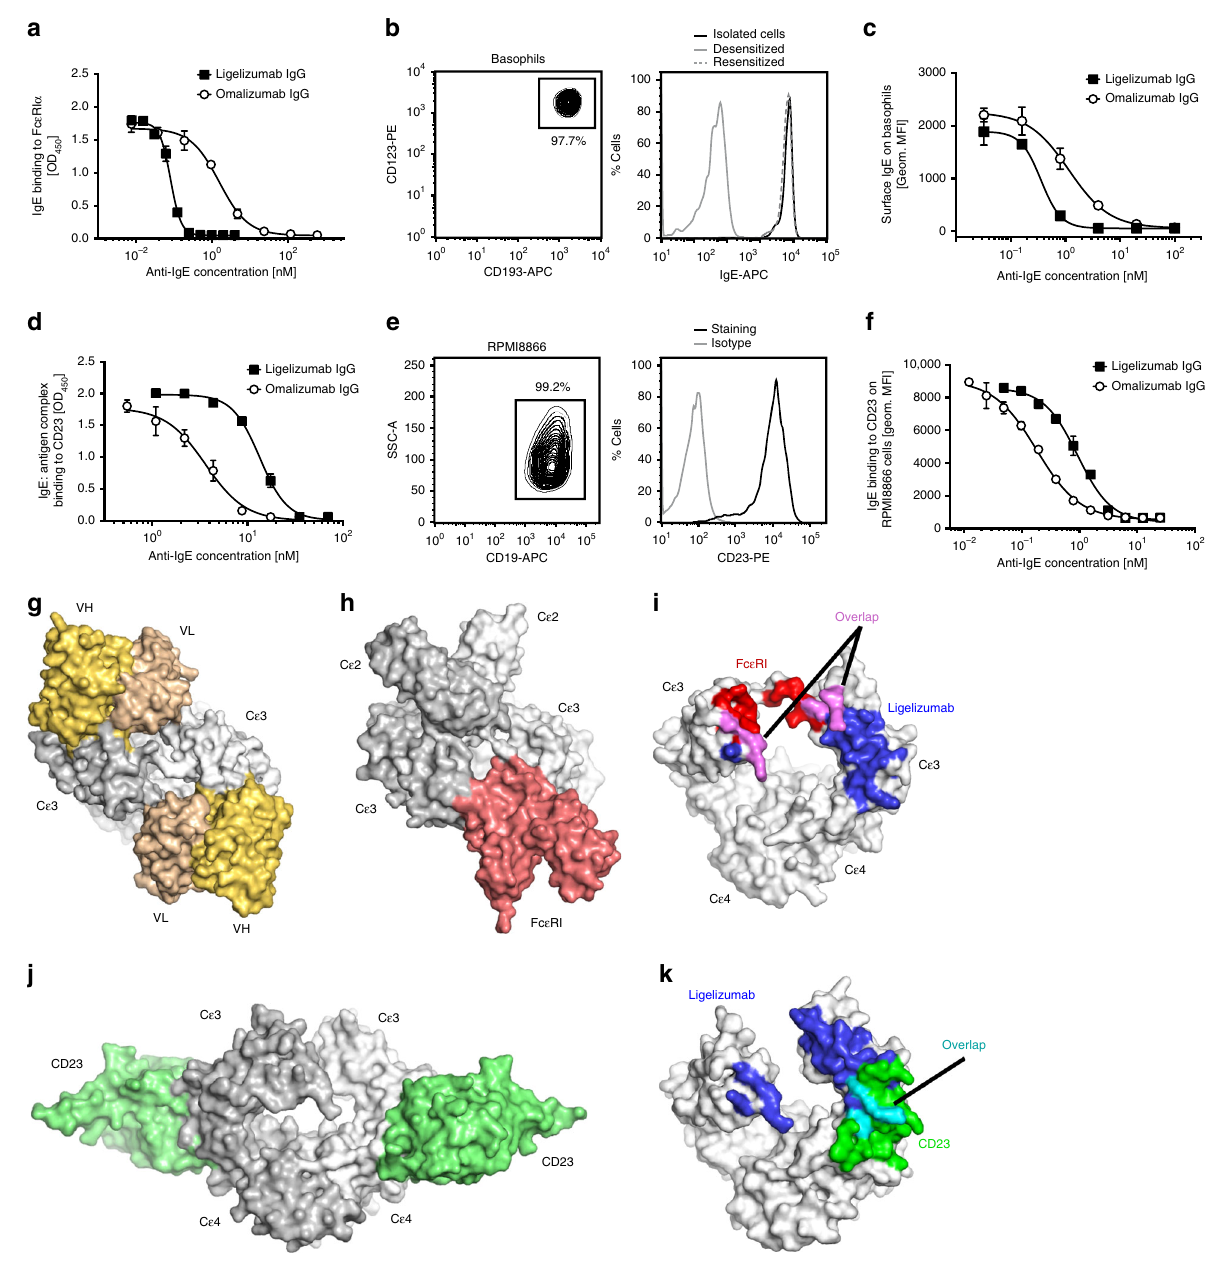
Fig. 2 Inhibition of IgE binding to Fc ε RI α and CD23 by ligelizumab or omalizumab. a Inhibition of IgE binding to Fc ε RI α through ligelizumab or omalizumab IgG by ELISA. b Isolated primary human blood basophils are gated as SSC low , FSC low , CD123 + , CD193 + double-positive cells. A histogram of basophil surface IgE levels before (black line) and after desensitization with 5 µ M disruptive-anti-IgE DARPin ® bi53_79 (gray line) and after resensitization with recombinant human JW8-IgE (dashed gray line) is shown. c Inhibition of IgE binding to Fc ε RI α on isolated bi53_79-treated basophils by ligelizumab or omalizumab IgG. Binding curves were fi tted using a non-linear regression model. d Inhibition of IgE:antigen complex binding to CD23 by ligelizumab or omalizumab IgG by ELISA. e Surface expression of CD23 on RPMI8866 cells by fl ow cytometry. f Inhibition of IgE binding to RPMI8866 cells by ligelizumab or omalizumab IgG. Binding curves (technical duplicates as mean ± SEM) were fi tted using a non-linear regression model. g – i Ligelizumab sterically blocks Fc ε RI binding overlaps with receptor-binding residues in both IgE subunits. g Ligelizumab complex in surface representation with the view along the IgE twofold axis (PDB ID: 6UQR). VH and VL domains are (light orange and wheat) and IgE subunits (white and light gray) are shown. h The structure of IgE- Fc 2-4 with Fc ε RI α (PDB ID: 2Y7Q 53 ) in surface format, with the receptor (salmon) and IgE chains (white and light gray). One ligelizumab scFv sterically blocks receptor binding, while second scFv overlaps the position of the IgE C ε 2 domains. i Overlap of IgE residues involved in both Fc ε RI and ligelizumab binding. IgE-Fc 3-4 in a surface representation is shown with common contacts shared by ligelizumab and Fc ε RI α (magenta), Fc ε RI α -speci fi c contacts (red) and ligelizumab-speci fi c (blue). j Structure of CD23:IgE-Fc 3-4 complex (PDB ID: 4EZM 57 ). IgE in surface representation with CD23 (light green). k IgE binding sites for CD23 have minimal overlap with ligelizumab epitope. IgE residues involved solely in ligelizumab binding (blue), those involved only in CD23 binding (green) and the overlapping contact residues (cyan) are shown. a , c , d , f Data shown for technical duplicates as mean ± SEM. Source data are provided as Source Data fi